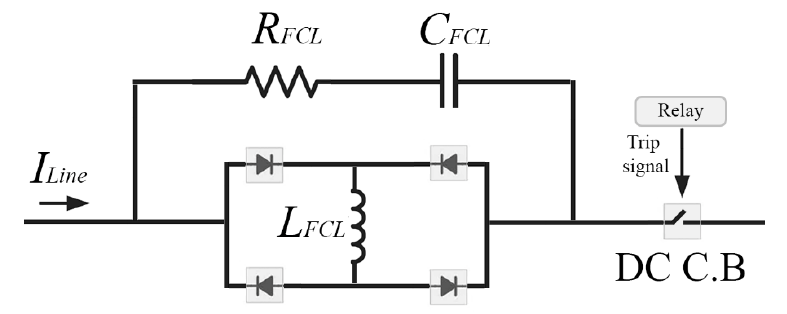
Figure 6. Proposed DC FCL configuration.